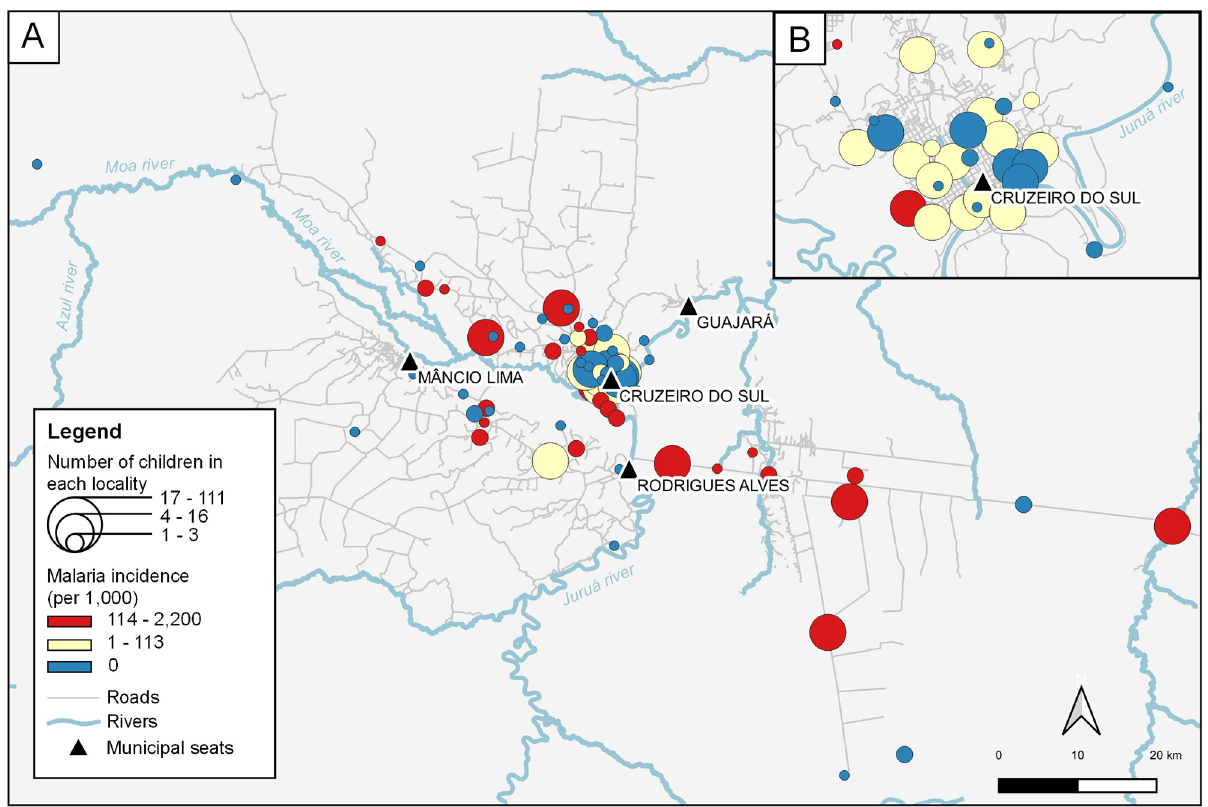
Fig 4. Spatial distribution of malaria incidence among MINA-Brazil study children. The map shows the upper Jurua´ Valley and the localities of residence of study children (circles) within and surrounding the municipality of Cruzeiro do Sul (A). The inset (B) shows the localities within and next to the urban area. Circle sizes are directly proportional to the number of study participants in each locality and their color (from blue to red) indicates the overall malaria incidence among study participants living in each locality (highest incidence in red). Roads and streets are represented in light gray. Rivers are represented in blue. Figure created with QGIS software version 3.14, an open source Geographic Information System (GIS) licensed under the GNU General Public License (https://bit.ly/2BSPB2F). Publicly available shape files were obtained from the Brazilian Institute of Geography and Statistics (IBGE) website (https://bit.ly/34gMq0S). Roads, streets, and rivers were obtained from the Open Street Map Foundation website (https://bit. ly/3pzh4xp). All utilized geographical data are under the Creative Commons Attribution License (CC BY